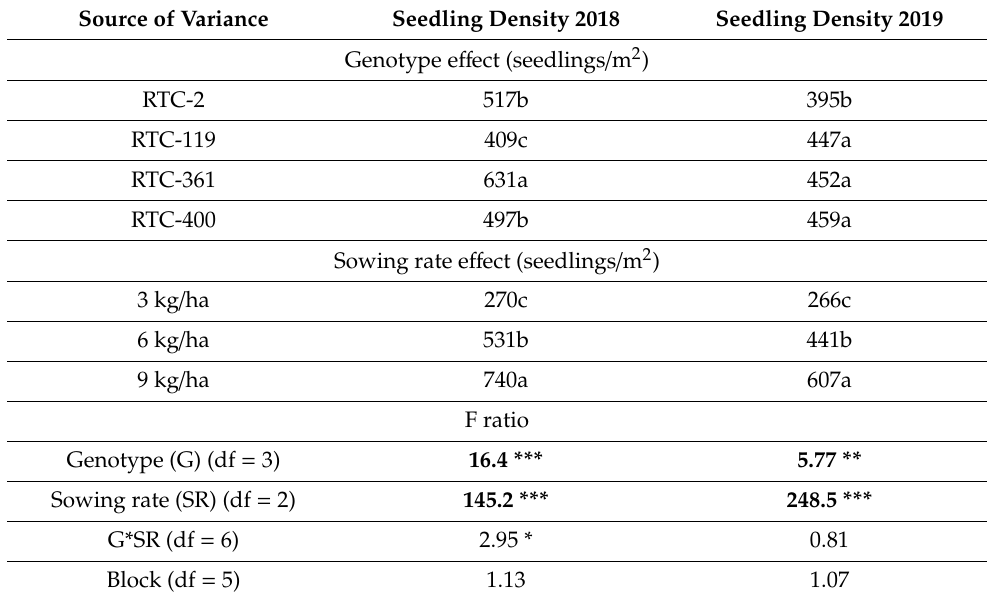
Table 1. E ff ects of genotypes and sowing rates on seedling density in the 2018 and 2019